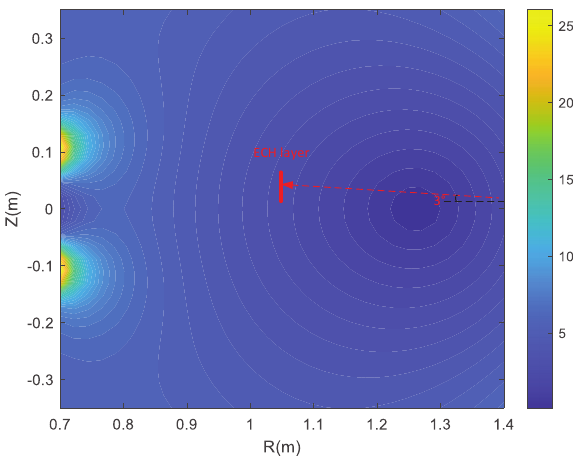
Figure 2. The magnetic field configuration (unit in Gauss) in cross-section When t = 0 s. ECH resonance layer is around the center of the vacuum vessel (R = 1.05 m, red square), where the stray-field is about 3 Gauss. The red dotted line is the schematic diagram of the EC propagation